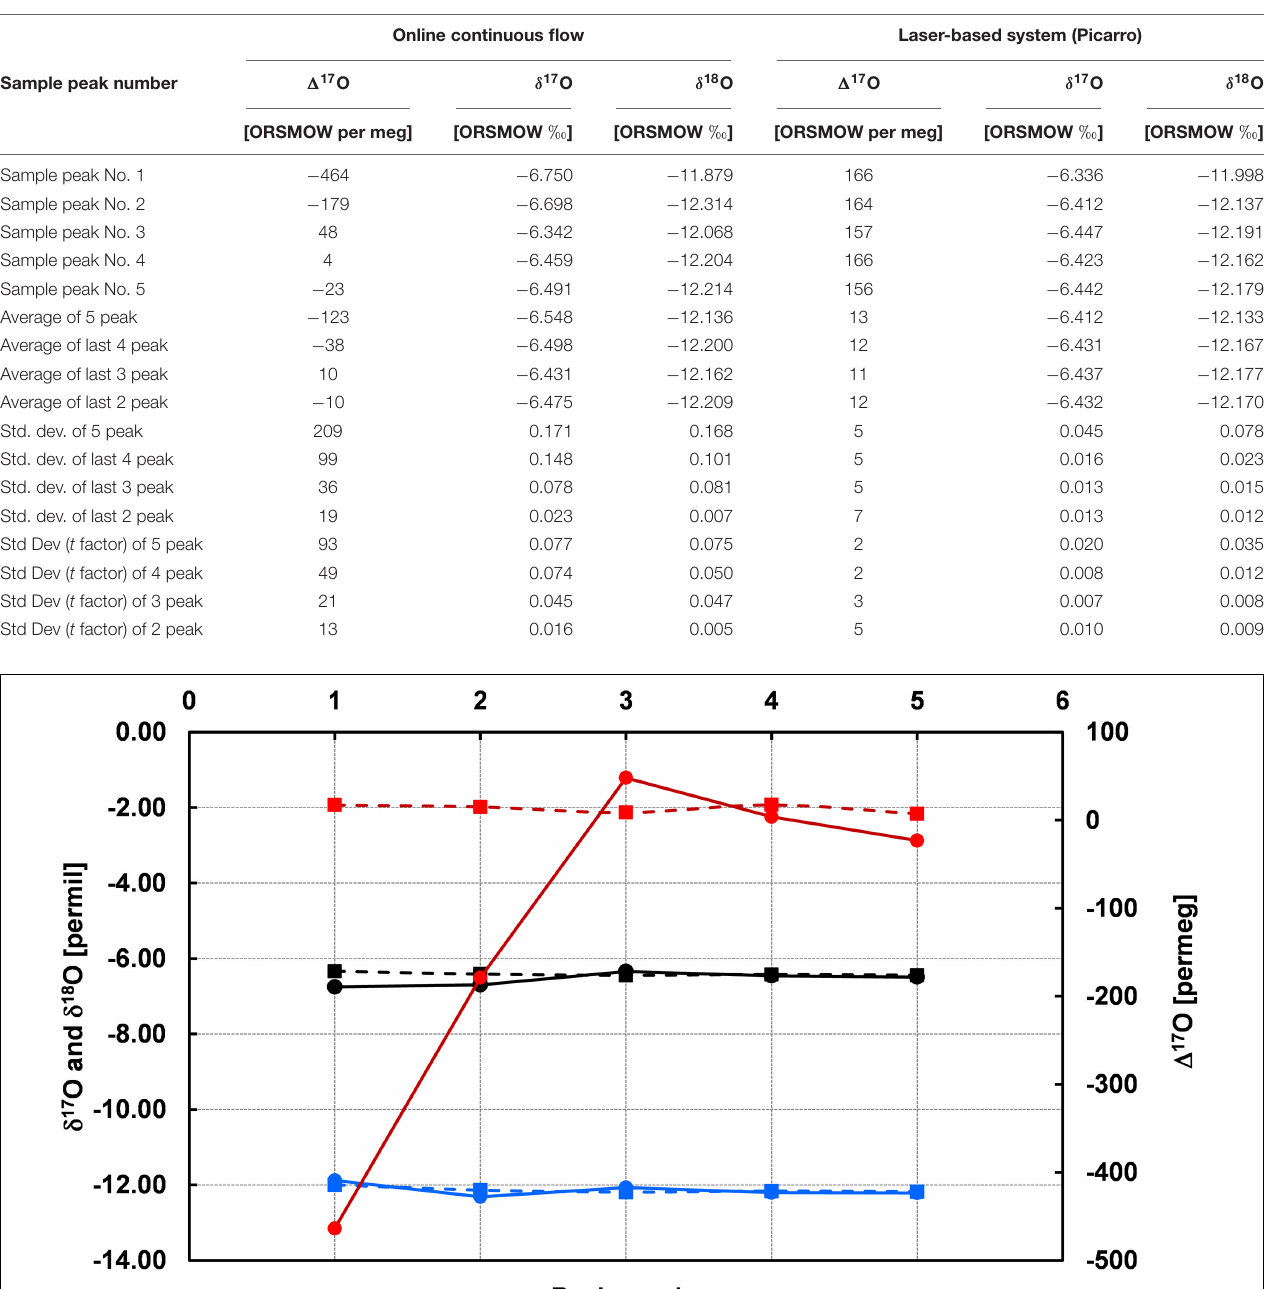
with average, standard deviation, and standard deviation by using students (cid:104)